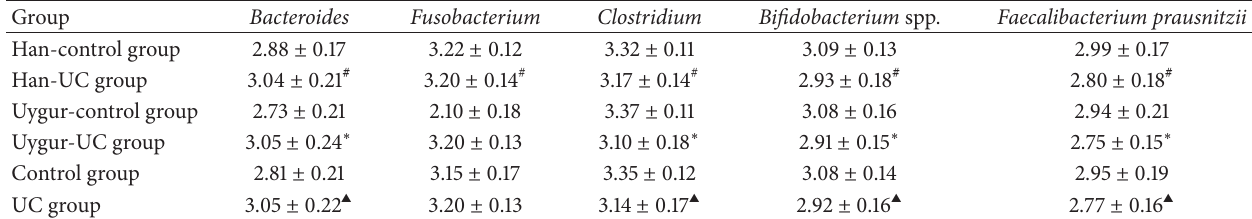
Table 4: The quantitative results of bacteria in feces in the case and control groups ( 𝑥 lg 𝑥 ± 𝑠 lg 𝑥 ). Group